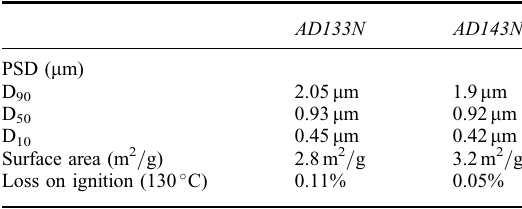
TABLE I Typical Powder Properties of AD133N and